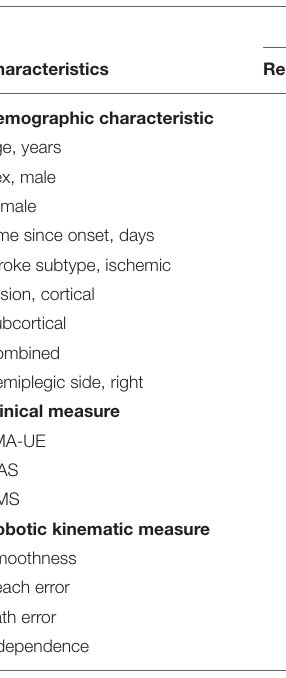
TABLE 1 | Baseline characteristics of responders and non-responders according to stroke